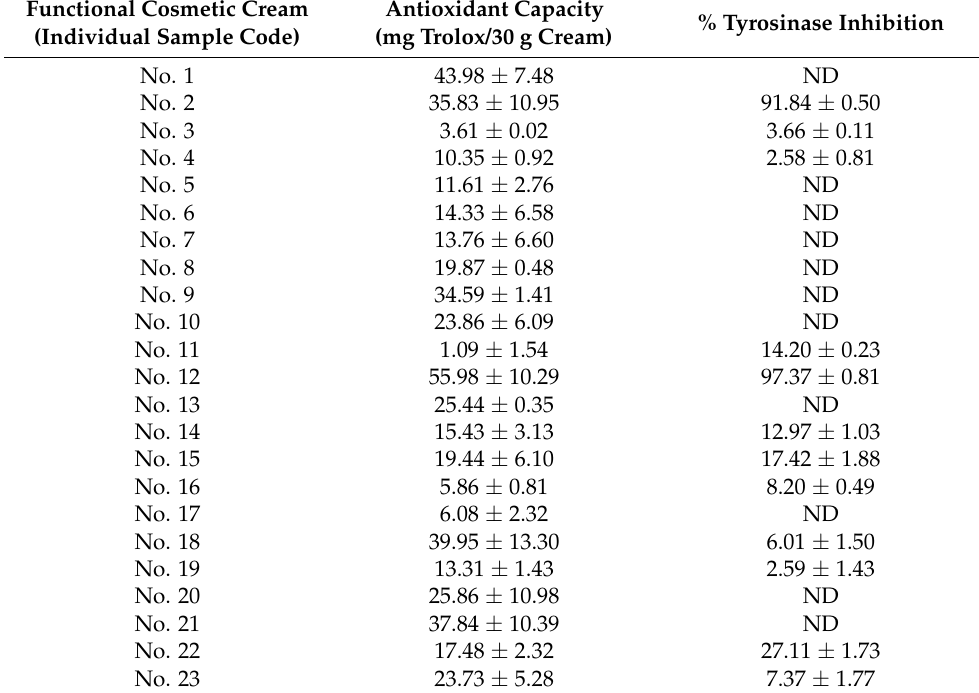
Table 2. Functional cosmetic cream samples obtained from the Thai market with their respective antioxidant capacity and % tyrosinase inhibition (total number of samples = 23).